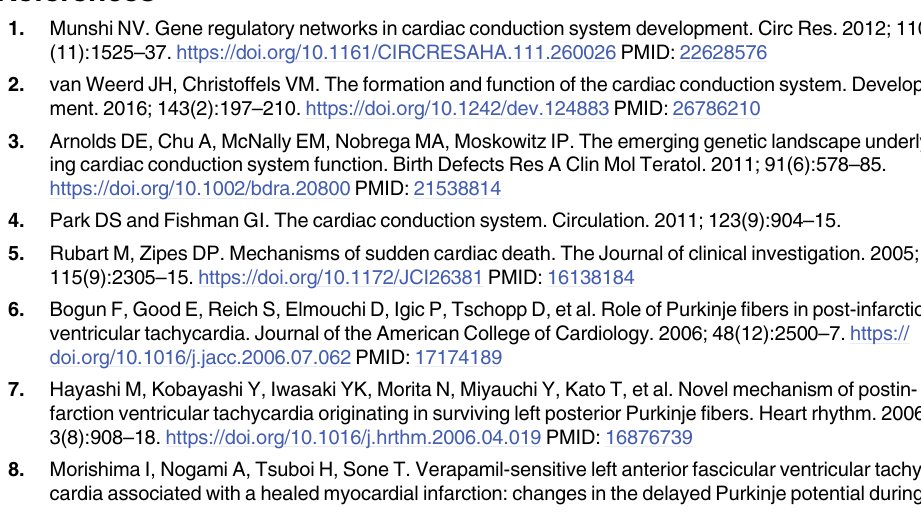
S1 Table. List of genotyping